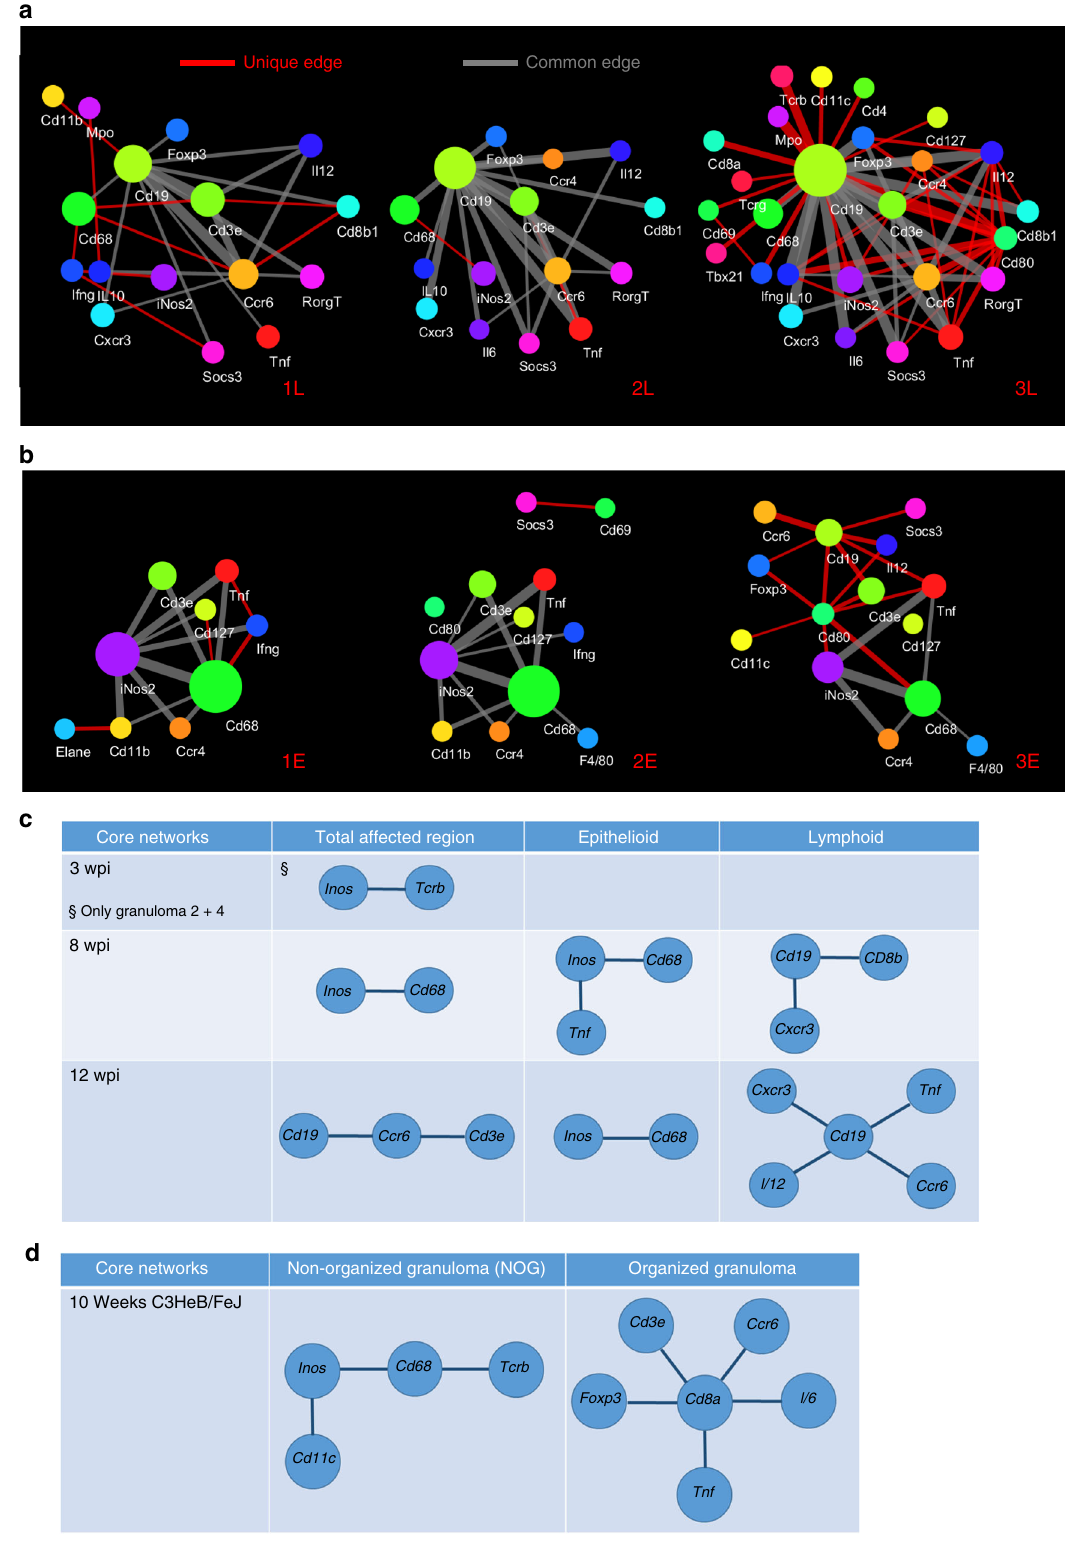
compartmentalization, CD68 + macrophages in the human tuberculous tissues do not form aggregates with B lymphoid clusters 17 . and Cd11b mRNA sequences at subcellular distances (<3 µm)